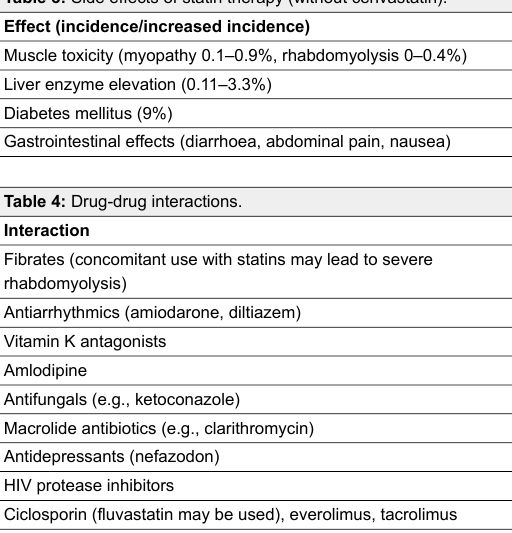
Table 4: Drug-drug interactions.